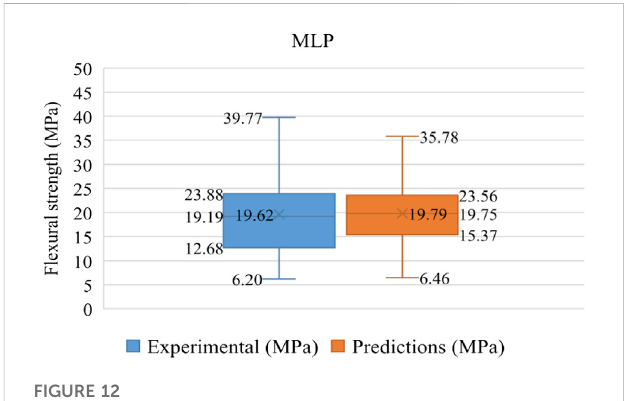
FIGURE 12 Box plot for actual and predicted results — MLP